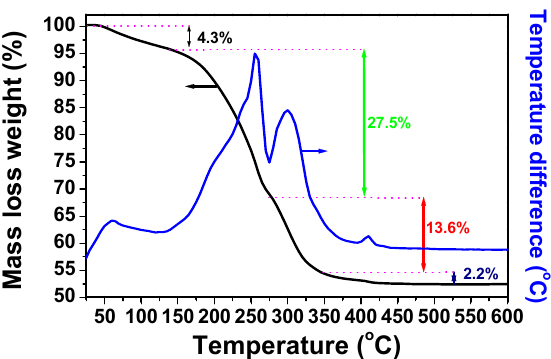
Figure 3. Thermal gravimetric and thermal differential curves of the synthesized complex from a mixture of nickel nitrate Ni(NO 3 ) 2 ·6H 2 O, ammonium molybdate (NH 4 ) 6 Mo 7 O 24 ·4H 2 O, and oxalic acid H 2 C 2 O 4 ·2H 2 O at 160 °C.